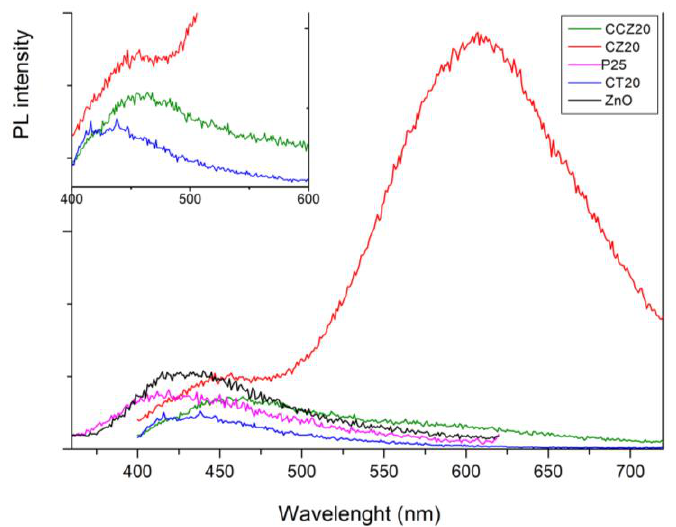
Figure 12. Photoluminescence of Ce-Ti and Ce-Zn composites was measured with a laser excitation wavelength of 380 nm, while bare ZnO and TiO 2 were investigated using a 320 nm laser